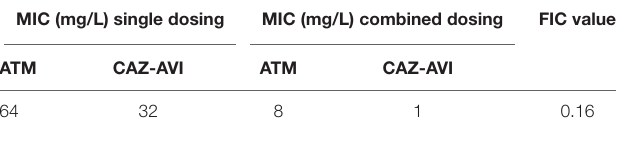
TABLE 1 | Results of MIC and AST of CAZ/AVI single dosing and combined with ATM against NY03. MIC (mg/L) single dosing MIC (mg/L) combined dosing FIC